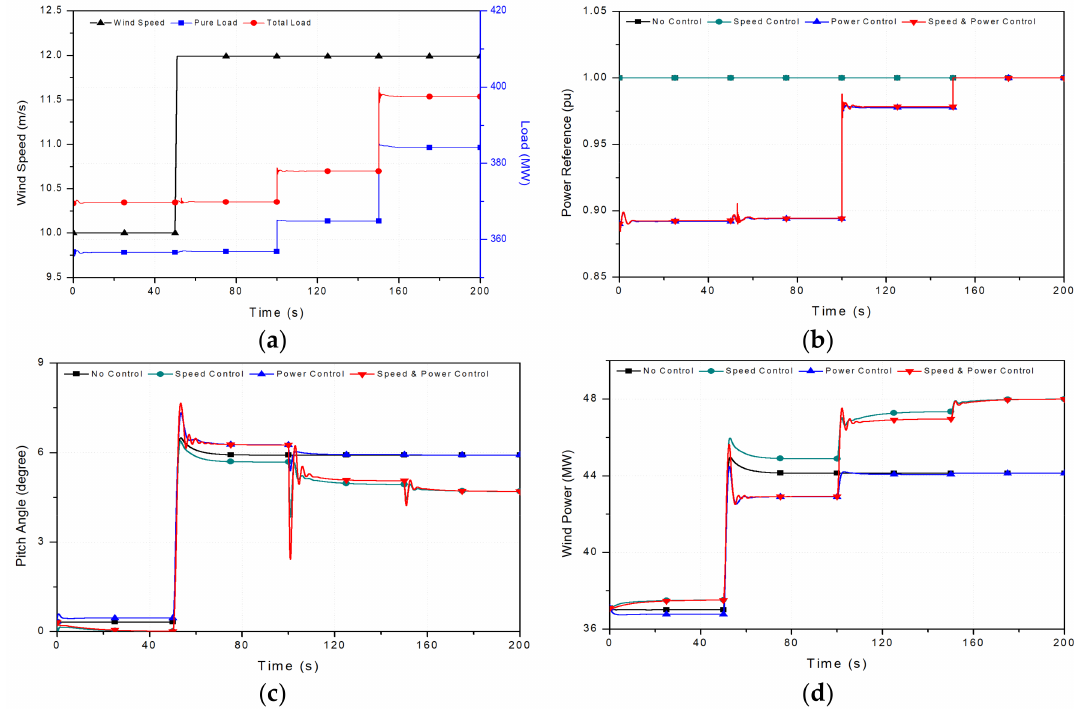
Figure 22. Simulation results when the power system load is increased (0~200 s): ( a ) Wind Speed and loads; ( b ) Power reference; ( c ) Pitch angle; ( d ) Output of wind turbine.